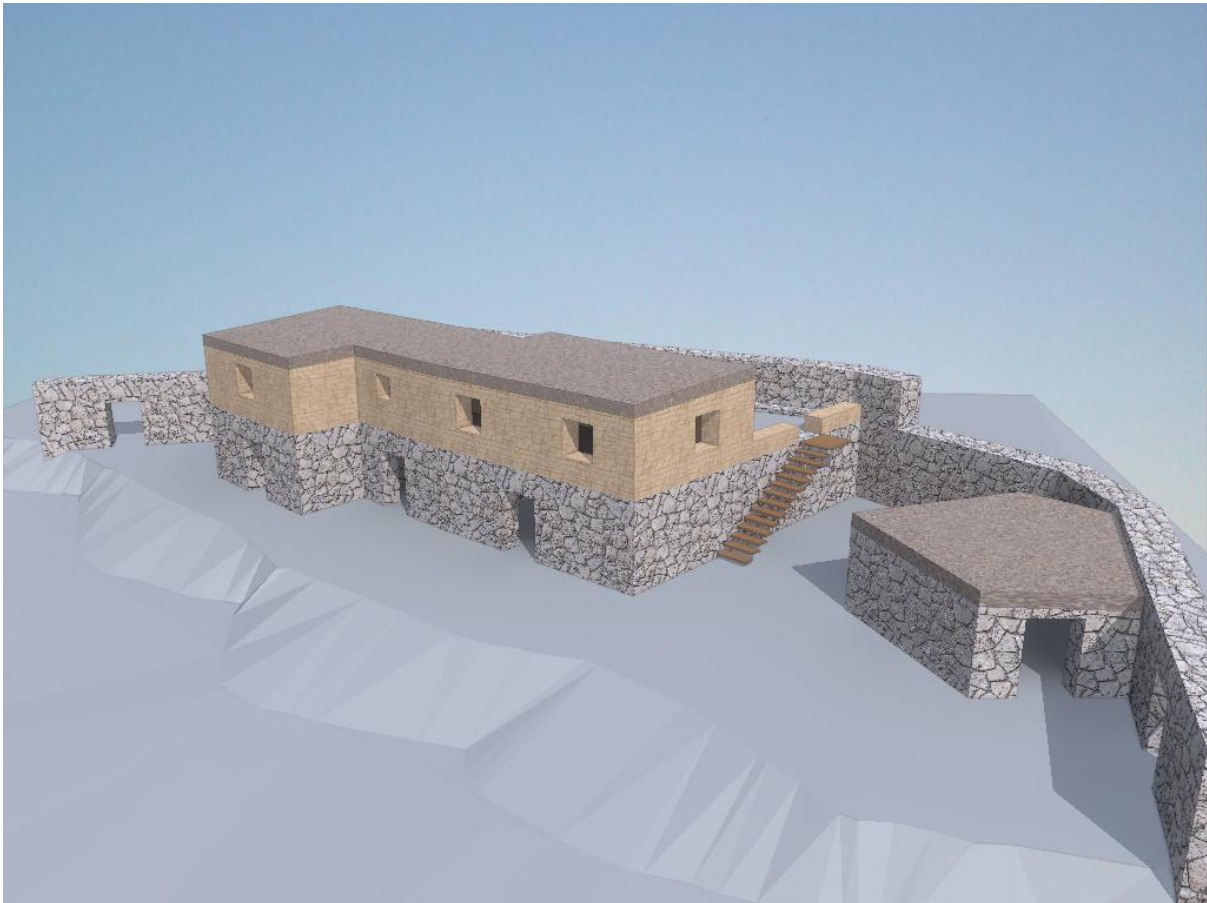
Figure 8. Agios Antonios Chomatas Site 9: ideal 3D reconstruction of the